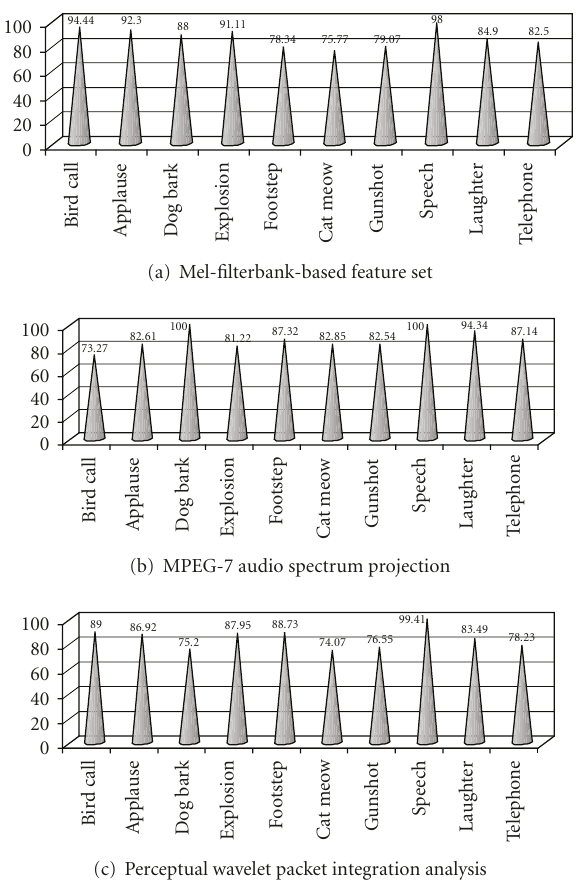
Figure 5: Recognition rates per sound class for (a) Mel filterbank, (b) MPEG-7 ASP, and (c) PWP Integration sets using the param- eters (length of texture window, number of states, and number of modes) that demonstrated the best overall accuracy.